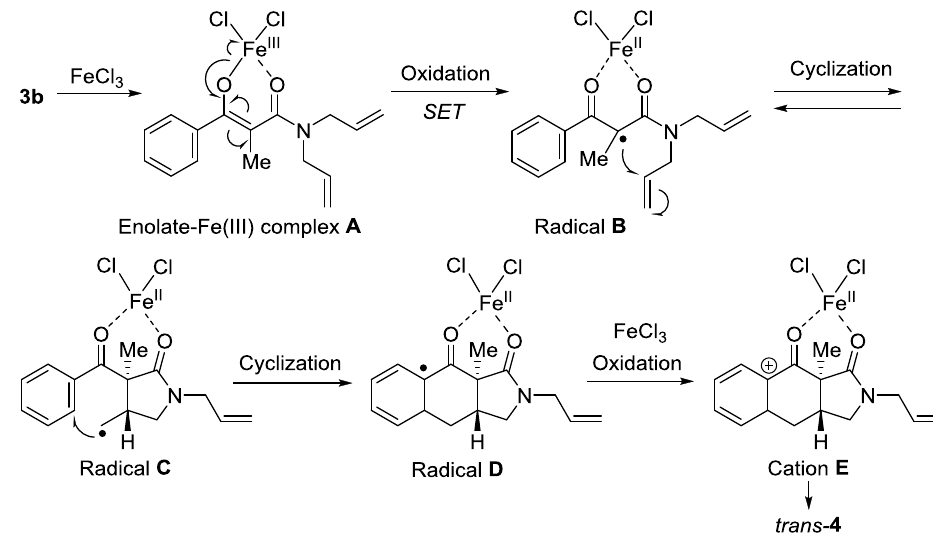
Figure 3. Possible reaction pathway.